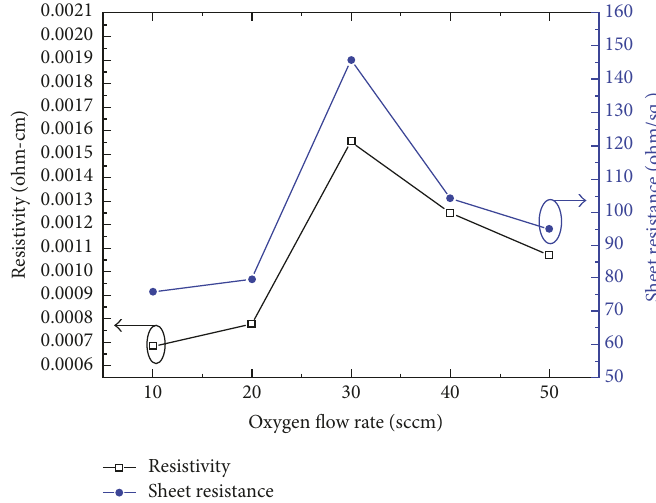
Figure 5: Resistivity and sheet resistance of ITO thin films deposited under different oxygen flow rates.